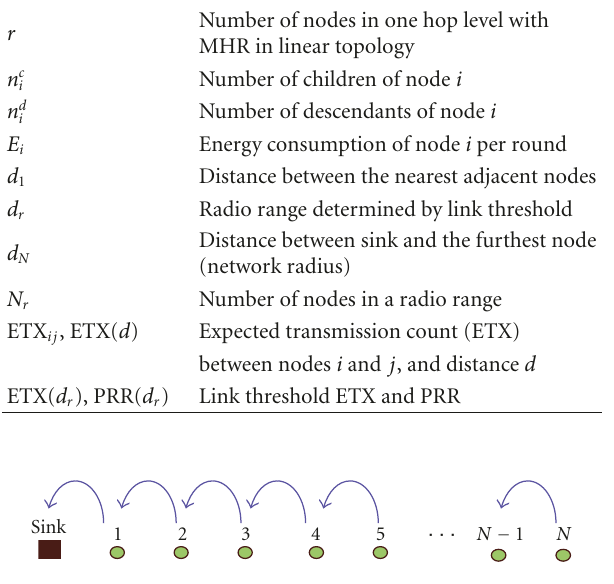
Figure 7: The lowest ETX parent selection scheme.